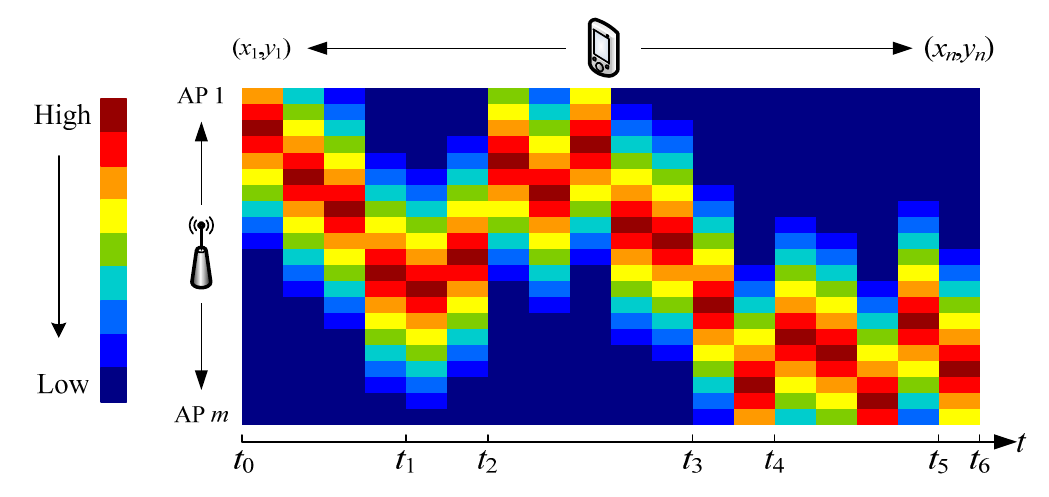
Figure 3. The desired radio map in WLAN positioning system.